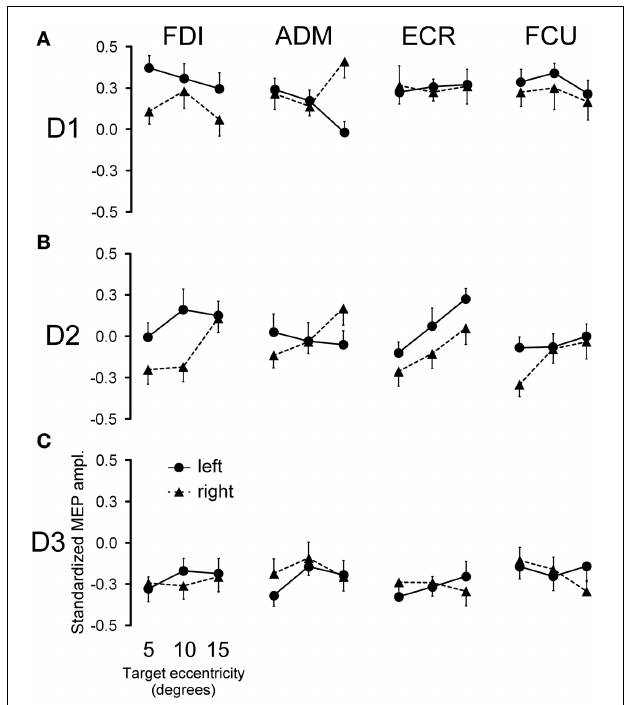
FIGURE 4 | Effects of saccadic target position on MEP amplitude. The modulation of mean MEP amplitude across all subjects following saccade execution is shown for each muscle. Points represent the mean standardized MEP amplitudes as a function of target eccentricity and visual hemi-field of presentation for TMS delay D1 (A) , D2 (B) , and D3 (C) . Error bars represent the standard error of the